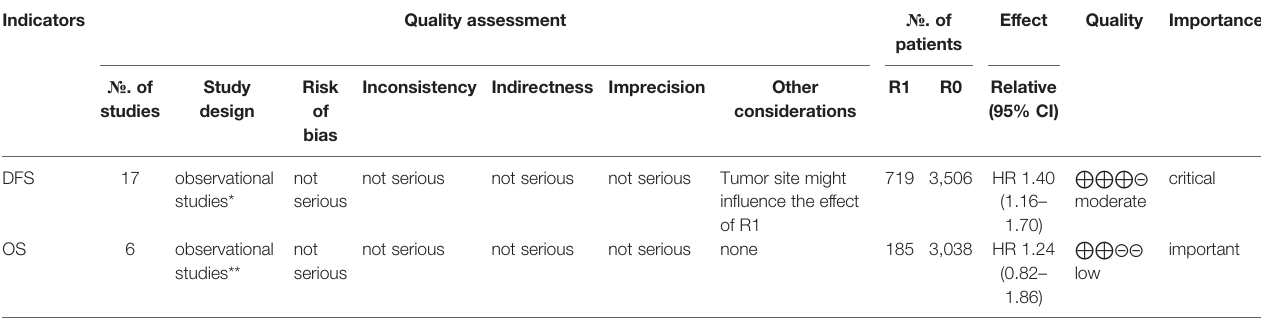
TABLE 2 | GRADE pro fi le evidence. Indicators